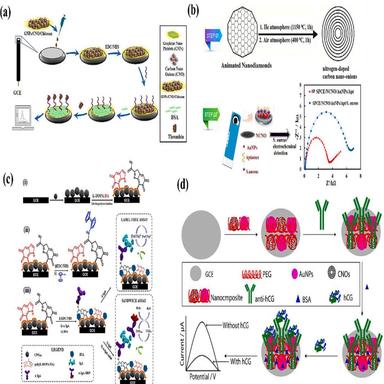
(a) Schematic showing the construction of thrombin aptasensor onto the surface of AuNPs/CNOs/CS-modified GCE, and (b) Gold/N-doped CNO-based sensor for quantitative determination of Staphylococcus aureus. (c) Diagram showing the procedures for: (i) modifying the GCE surfaces by using CNOoxi and poly(L-DOPA/ DA) film; (ii) attaching amino-ferrocene; and (iii) designing the two electrochemical assay designs for IgA antibody detection (d) Development of a CNOs/AuNPs/ PEG nanocomposite as an hCG-biosensor for t